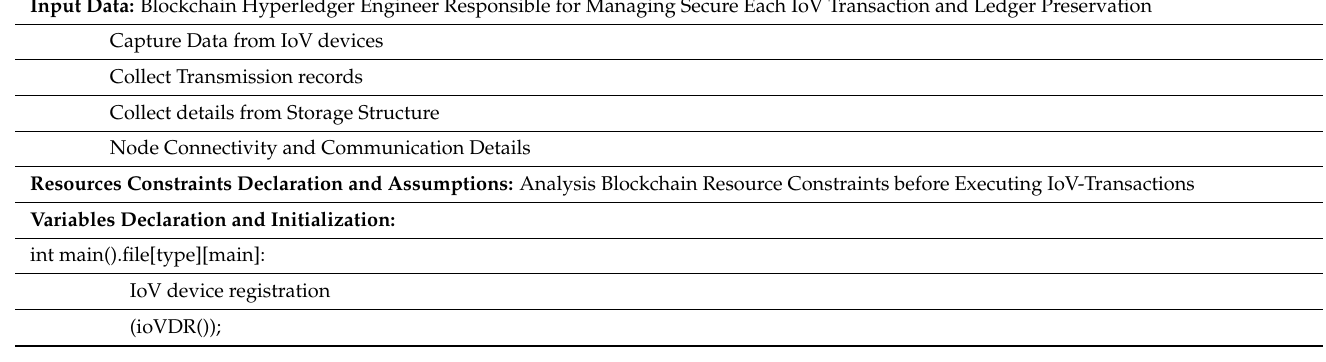
Table A1. Pseudo-Implementation of the Proposed Lightweight-BIoV Smart